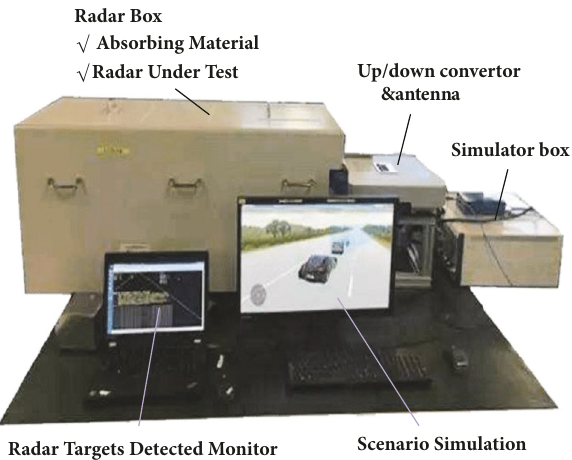
Figure 9: The semiactual object simulation system of the driving